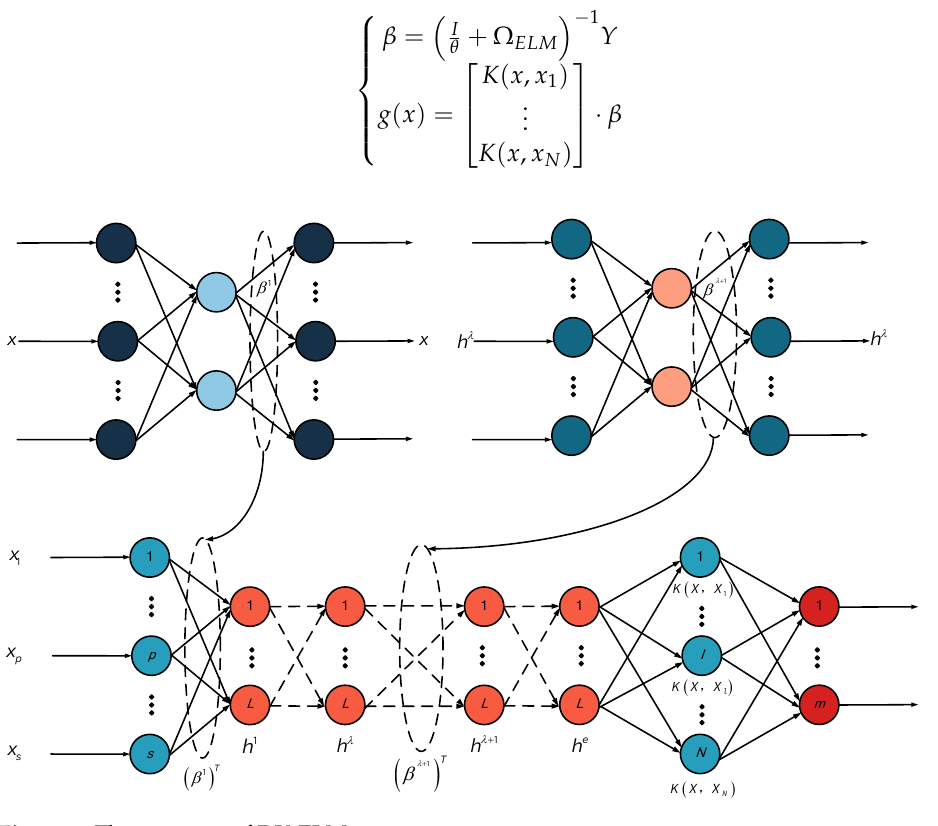
Figure 2. The structure of DK-ELM.